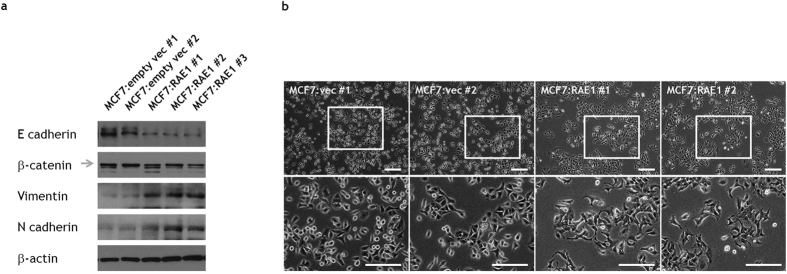
Effect of RAE1 overexpression or knockdown in breast cancer cell lines.(a) Immunoblot analysis of E-cadherin, β-catenin, vimentin, and N-cadherin expression in stable RAE1-overexpressing MCF7 cells. Full-length blots are presented in Supplementary Fig. 3. (b) A morphological change from a cobblestone shape to an elongated spindle shape was observed in MCF7 cells after inducing RAE1 overexpression. Scale bar = 200 μm.